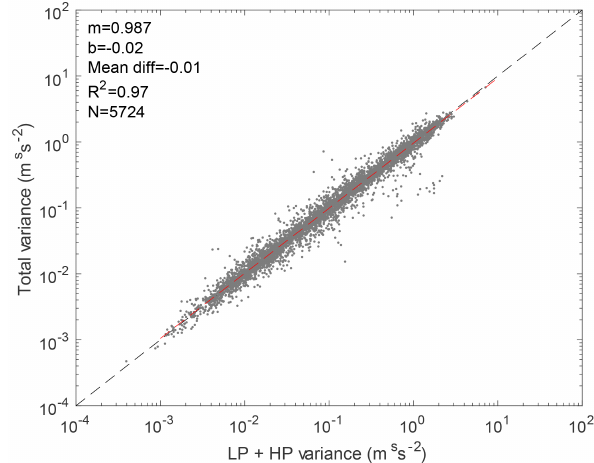
Figure 4. Scatter plot of the total sonic anemometer variance ver- sus the sum of low-passed (LP) and high-passed (HP) variances from sonic anemometers, with the time-separation interval set to the 449MHz, un-averaged (NSPEC = 1) dwell time of 13s. The black dashed line is the one-to-one line. Data from all six heights of sonic anemometers, from the start of each instrument’s measurements to 30 April 2015, are included. Also shown are the slope ( m ) and in- tercept ( b ) of the best fit line (red dashed line), as well as the mean difference and coefficient of determination and the number of points